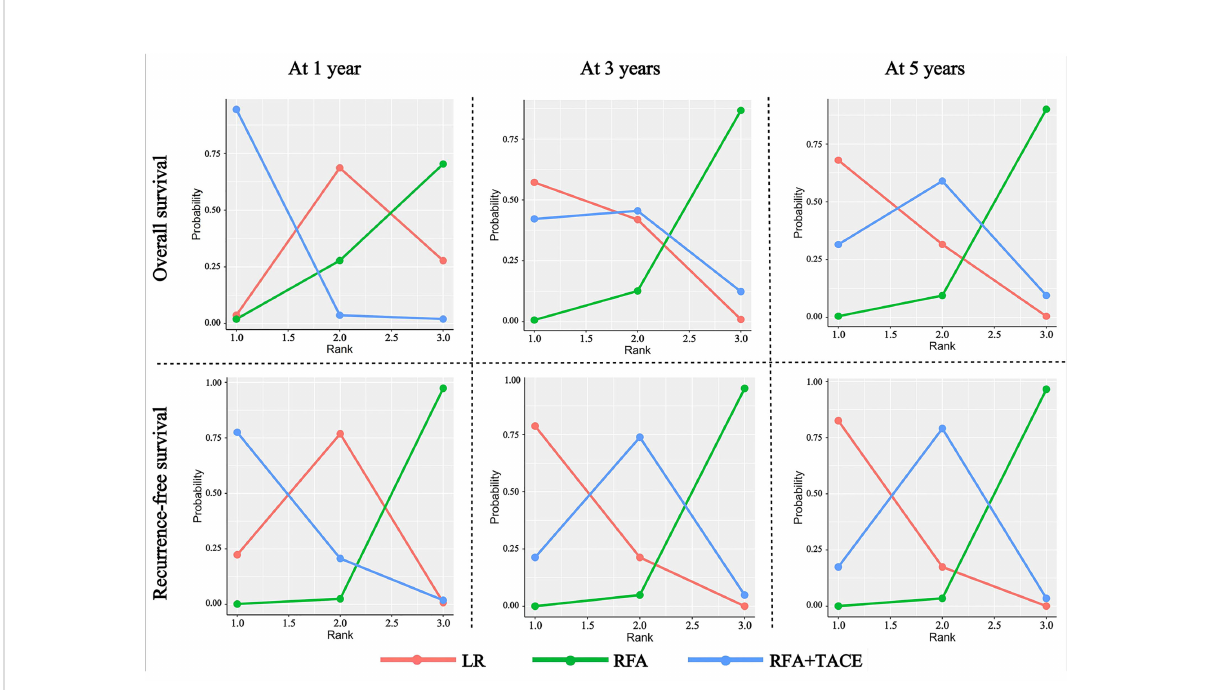
FIGURE 3 Rank probability of LR, RFA+TACE, and RFA based on each outcome criteria evaluated in the